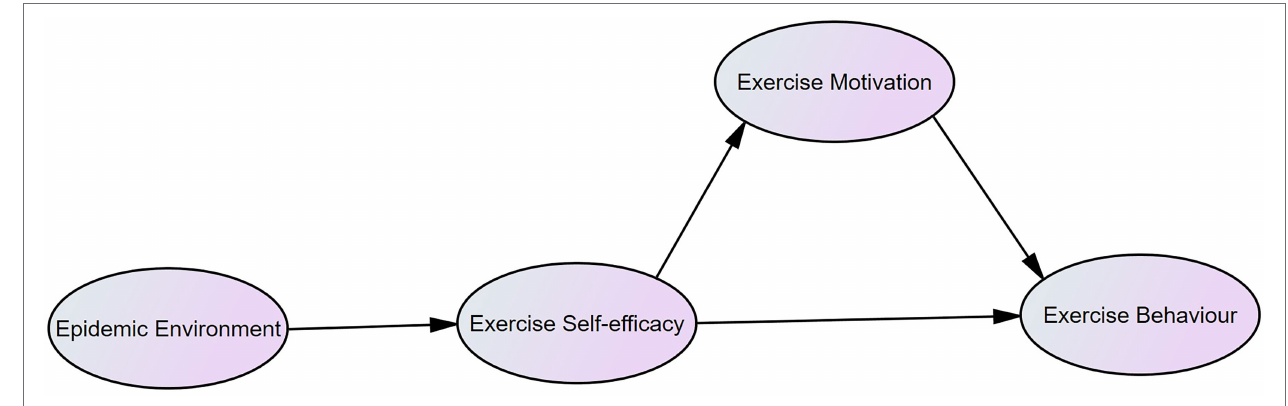
FIGURE 1 | The path map of the influence of the COVID-19 epidemic environment on physical exercise motivation, self-efficacy, and